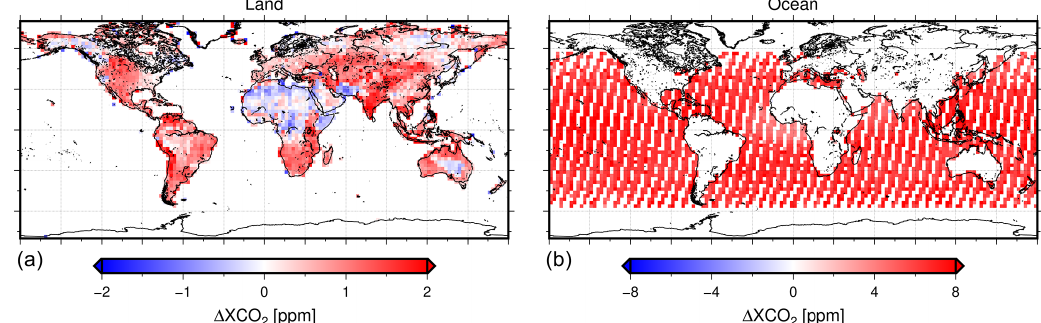
Figure 15. Difference of XCO 2 between V03.00 and bias-corrected one (bias-corrected minus V03.00) over land (a) and the ocean (b) , av- eraged from the launch to 2021 within 2.5 ◦ × 2.5 ◦ grid boxes.